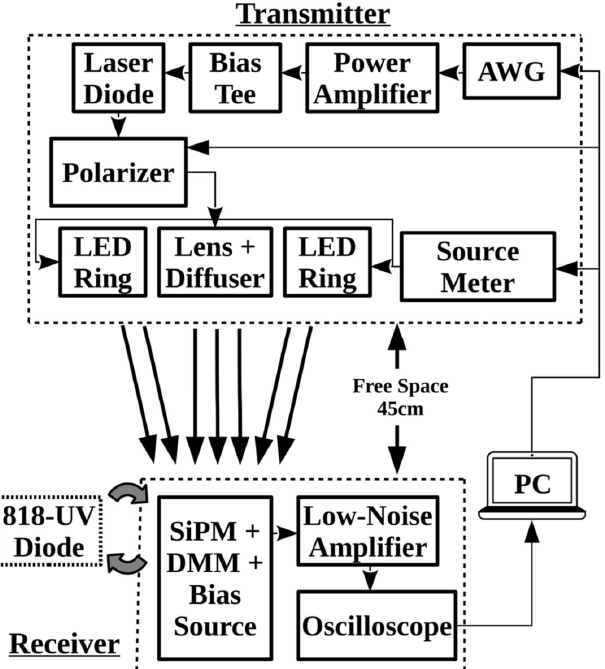
Figure 3. System block diagram describes the experimental setup used to evaluate the ambient light performance of the SiPM. The AWG was a 25 GS/s AWG70002A, the Power Amplifier is a Fairview FMAM3269 10 MHz to 6 GHz Amplifier, which feeds a Bias Tee (Thorlabs ZFBT-4R2GW+) and the Laser Diode a ThorLabs L405P20. The LED ring includes eight UV3TZ-405-15 LEDs, and is driven by a Keithley 224 Source Meter. During some experiments, the bias voltage applied to these 405 nm LEDs was varied to control the effective ambient light level. On the receiver side, the SiPM is coupled to a ZX60-43-S+ 4 GHz Low Noise Amplifier, which feeds a Keysight MSO64 (4 GHz, 25 GS/s) oscilloscope. The polarizer, source meter, AWG and oscilloscope are computer-controlled by MATLAB ® . Table 1. Key parameters obtained from the manufactures data sheet for a j series 30020 [26].